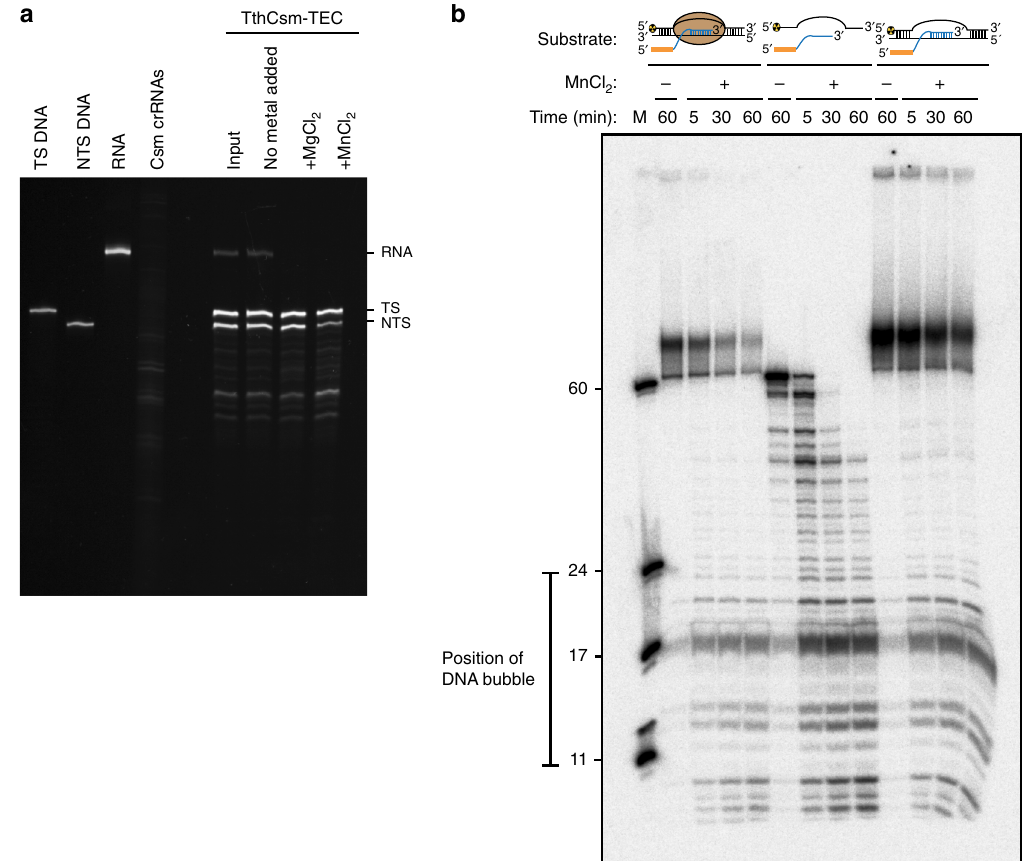
Fig. 4 Target preference of TthCsm at the transcription bubble. a Cleavage of nucleic acids by TthCsm in the TthCsm-TEC complex was initiated by addition of MgCl 2 or MnCl 2 and reactions were incubated for 30 min at 65 ˚ C. Products were analyzed by denaturing PAGE and SYBR gold staining. The nontemplate strand (NTS DNA), template strand (TS DNA), RNA transcript (RNA), and crRNAs contained in the TthCsm (Csm crRNAs) were loaded individually on the left half of gel for comparison. b TthCsm-catalyzed cleavage of the 5´-radiolabeled NTS. The substrates tested were the eluted TthCsm- TEC sample from the pull-down (left), the NTS DNA alone with the target RNA transcript, which includes a sequence complementary to the TthCsm crRNA (center), and an R-loop bubble composed of NTS DNA, TS DNA, and the target RNA transcript (right). A ssDNA marker was run in the leftmost lane (M), and the position of the unpaired region is shown. Uncropped gel images for ( a , b ) are available online in the Source Data fi